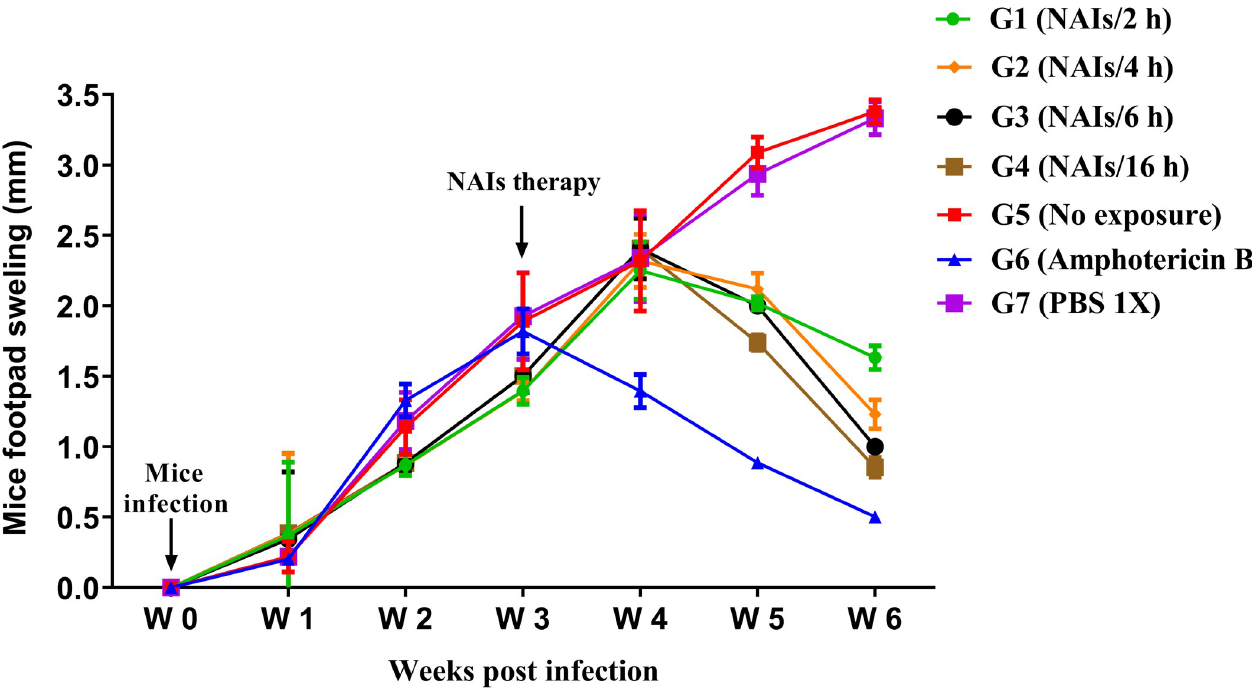
Fig 2. Experimental CL lesion development or swelling of right footpad (FP) in Leishmania major (2 × 10 6 metacyclic promastigotes) infected BALB/c mice before and after NAIs therapy (after the end of treatment, five mice from each group were randomly selected). The CL lesion size was reported using a metric caliper tool by measuring the increase in right infected FP thickness/width from 1 to 6 weeks p.i. The results of one out of three independent experiments are shown, all presenting similar outcomes. Results are elucidated as the mean ± SE and student t-test was used for statistical analysis ( � P < 0.05, �� P < 0.01, ��� P < 0.001).